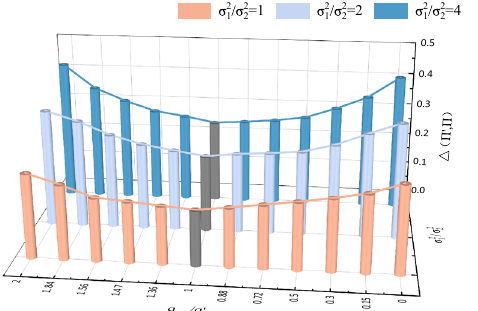
Fig. 8 Steane type error correction scheme. the red histogram in the fi gure indicates that Δ ð π 0 ; π Þ is a schematic diagram of Steane type error correction adjustment; The light blue histogram represents a schematic diagram of Steane type error correction is twice as much as σ 2 ; the dark blue histogram adjustment when σ 2 1 2 is a schematic diagram of Steane type error correction represents σ 2 1 . From the fi gure we can see adjustment in the case of four times σ 2 2 that Q COR ¼ Q ð ME Þ is the best correction to minimize Δ ð π 0 ; π Þ COR